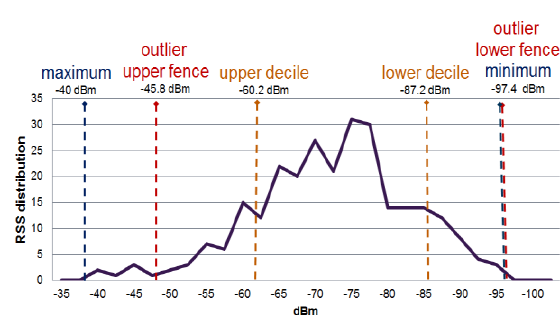
Figure 9. Typical cell RSS profile of an intra-BS neighbour showing the four patterns